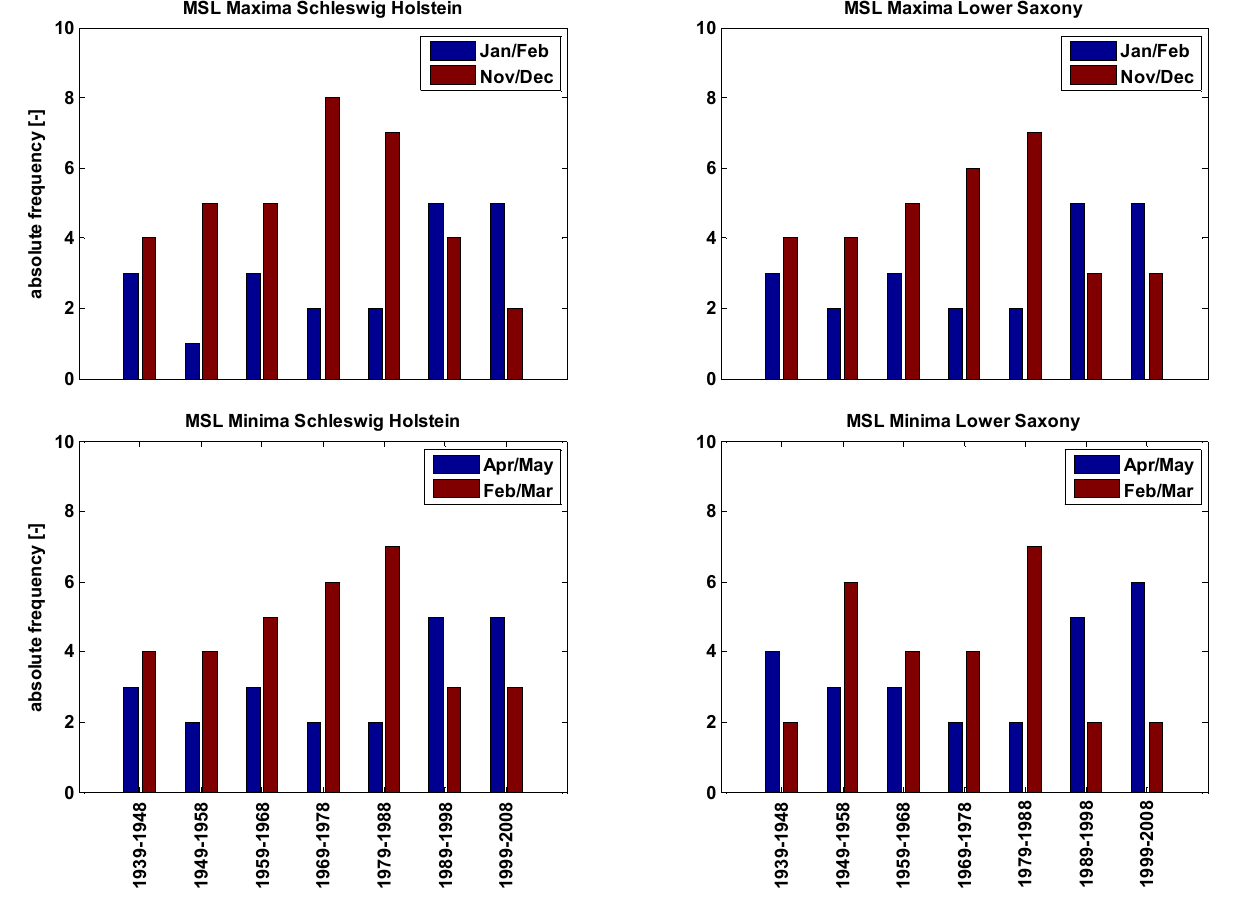
Figure 3. Development of the occurrence time of maximum (N–F) and minimum (F–M) values of the seasonal cycle over the last seven decades between 1939 and 2008 for the two virtual stations Schleswig Holstein ( left ) and Lower Saxony ( right